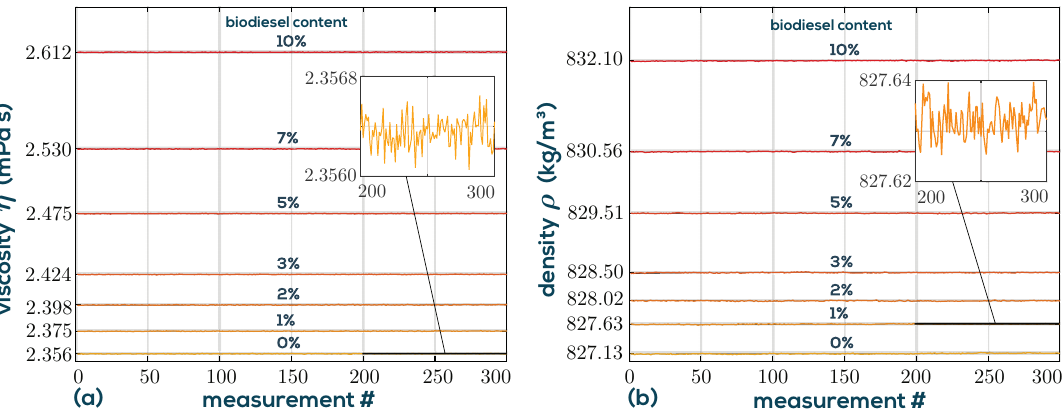
Figure 9. Sample series of viscosity ( a ) and density ( b ) measurements for varying concentrations at a temperature of T = 15 ◦ C recorded at a rate of 1 sample/s. Each of the 300 samples is individually